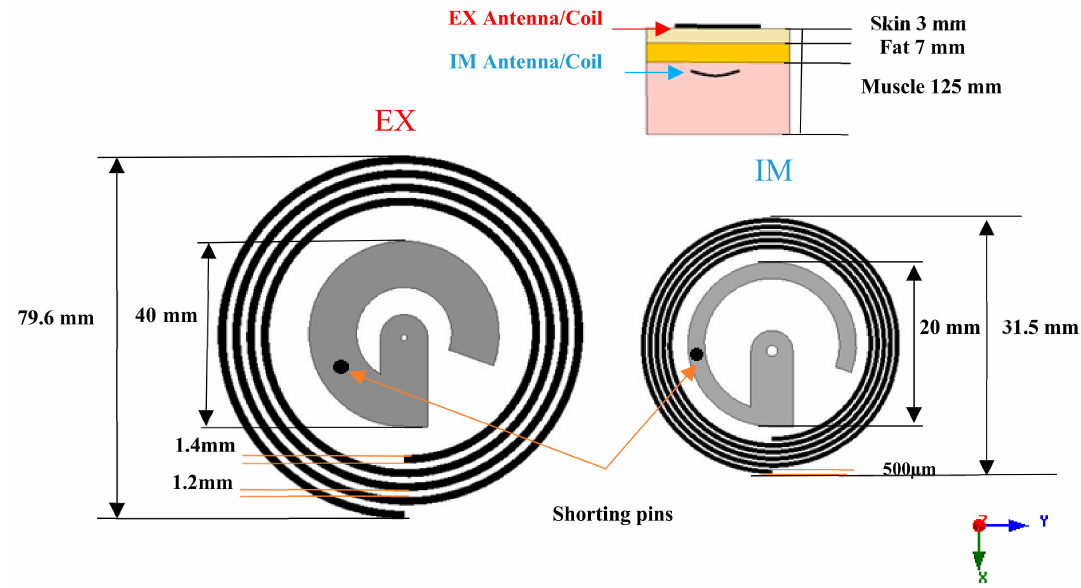
Figure 1. Coil and antenna configuration for the external antenna / coil combination (EX) and implanted system (IM) and their location, with respect to the layered body